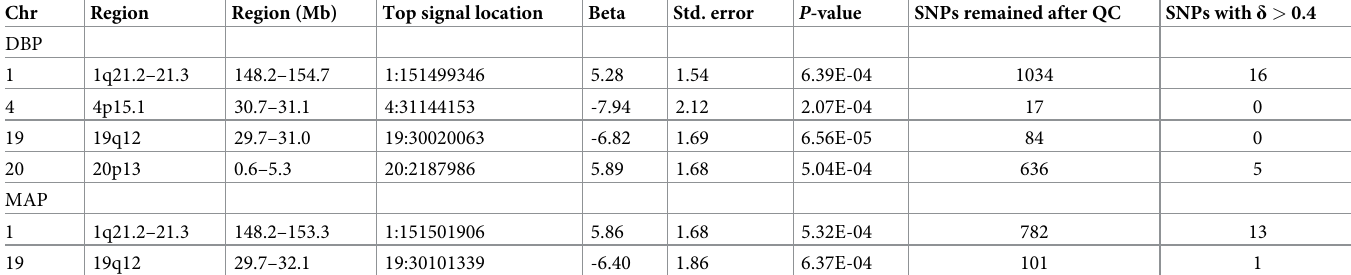
Table 2. Significant regions showing the association between blood pressure and African